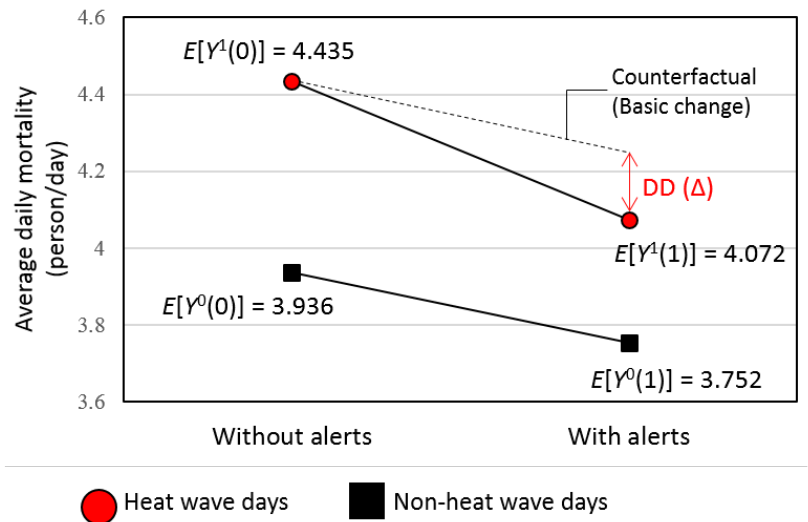
Figure 1. Average all-cause mortality (person) per day for the heat wave categories (2009–2014). Notes. DD: difference in difference, 𝐸[𝑌 0 (1)] : mortality in false positive heat wave days, 𝐸[𝑌 1 (1)] : mortality in true heat wave days, 𝐸[𝑌 0 (0)] : mortality in true non-heat wave days, 𝐸[𝑌 1 (0)] : mortality in false negative heat wave days. The noted DD is the estimated effectiveness of the heat wave alerts adjusted for the counterfactual mortality difference for non-heat wave days (comparison group) with and without heat wave alerts.